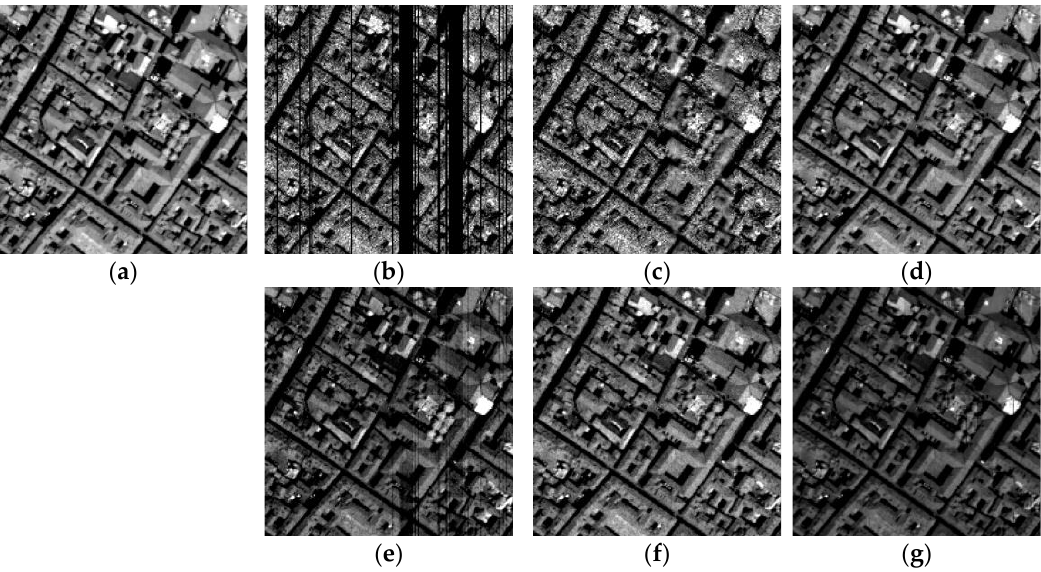
Figure 5. Inpainting results of band 60 of Pavia Centre dataset with Poisson noise. ( a ) Clean image; ( b ) noisy image; ( c ) PDE; ( d ) UBD; ( e ) LLRSSTV; ( f ) BPFA; and ( g )